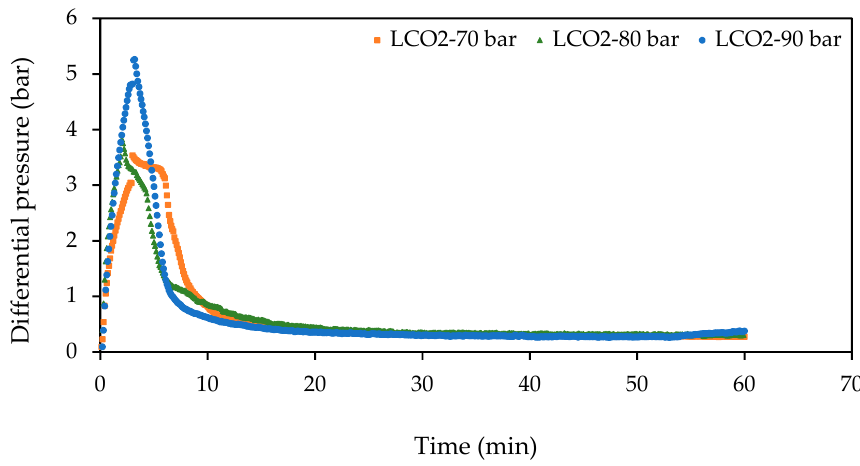
Figure 5. Effect of fluid pressure on the differential pressure profile of LCO 2 –oil displacements conducted at 0.4 mL/min and 20 °C.